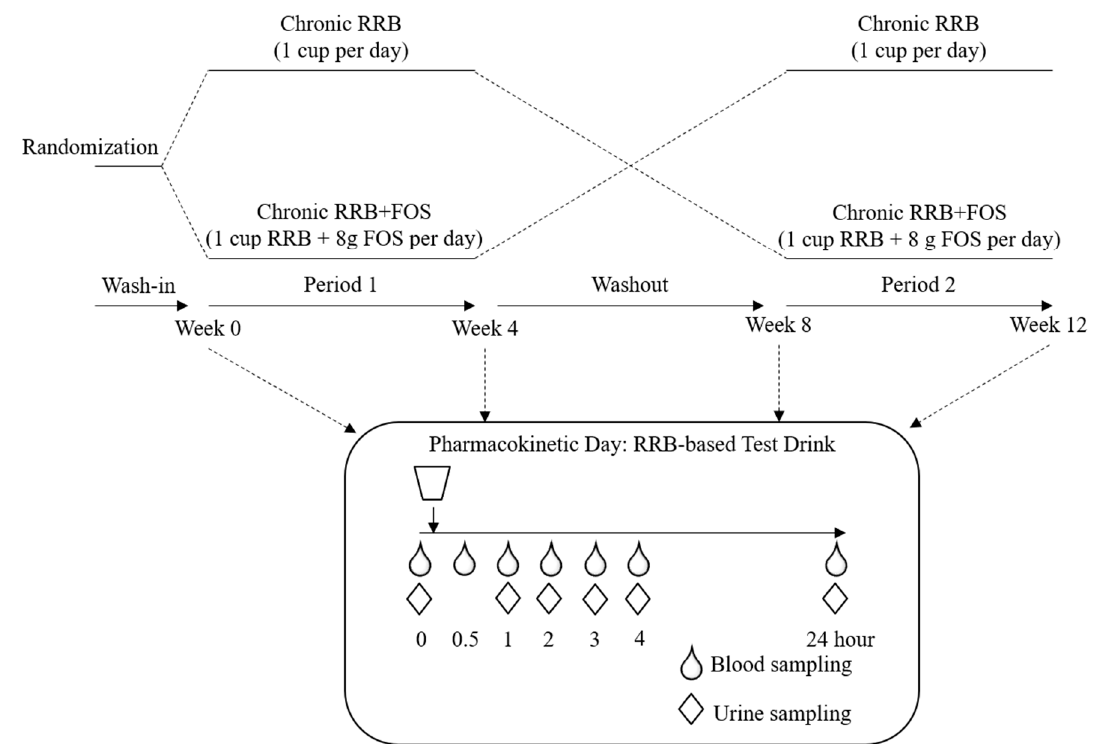
Figure 2. Study design and pharmacokinetic day schema. Table 1. Subject demographic characteristics at baseline 1 .